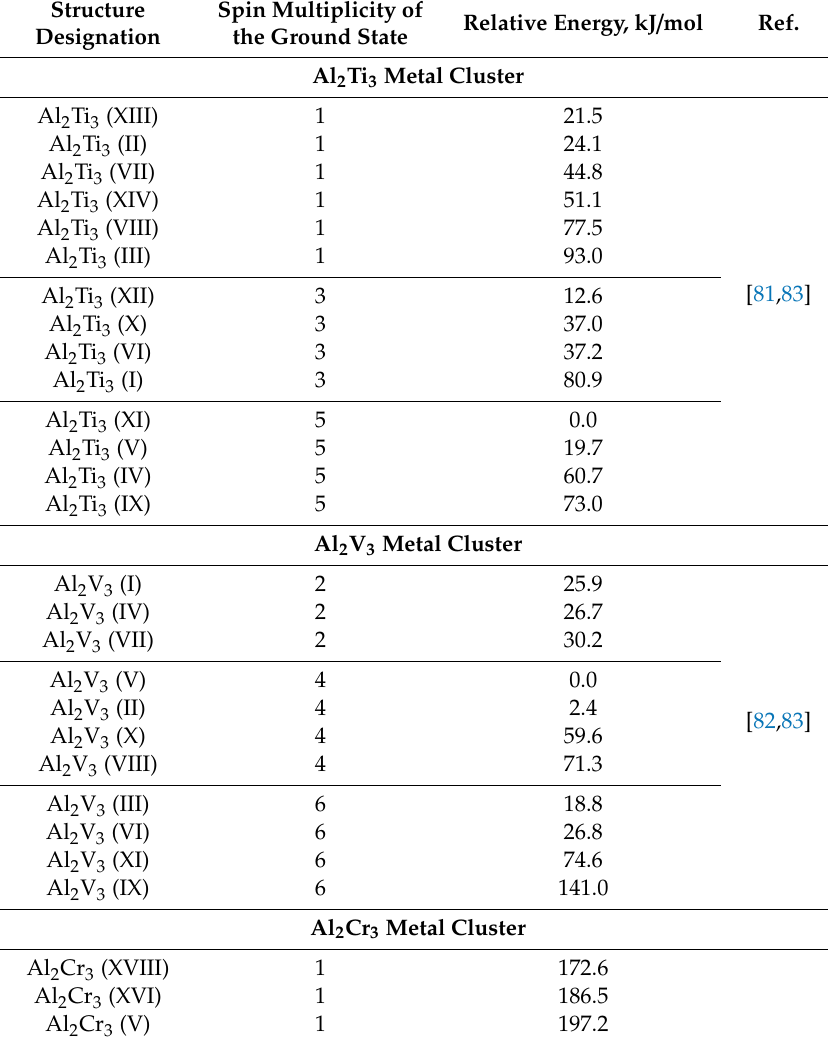
Table 4. Relative energies and spin multiplicities of the ground states of various isomers of 3 d